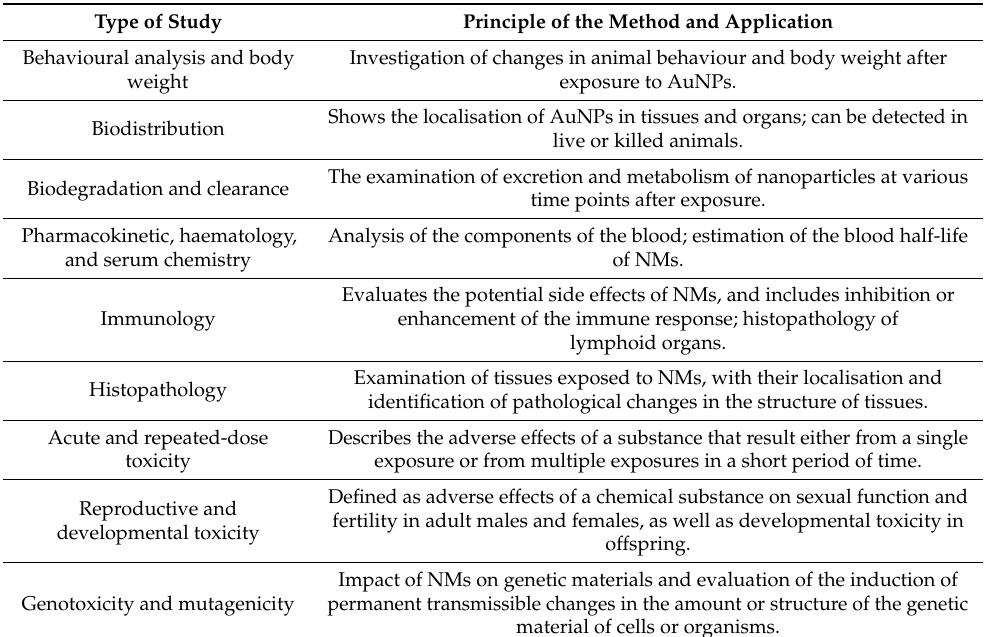
Table 2. Types of in vivo studies and their main principles used to assess the biocompatibility of NMs